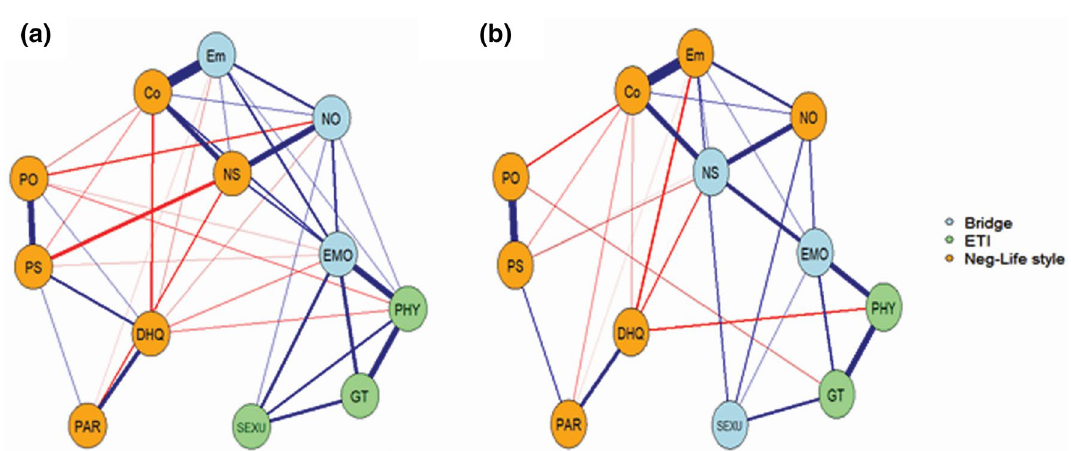
Figure 5. Bridge symptoms between two domains (childhood trauma and negative life style) in ( a ) patients and ( b ) controls. Abbreviation: same as in the Fig. 1. The R-packages ‘mgm (version 1.2–12 and URL https:// CRAN.R- proje ct. org/ packa ge= mgm)’ and ‘qgraph (version 1.6.9 and URL https:// CRAN.R- proje ct. org/ packa ge= qgraph)’ were